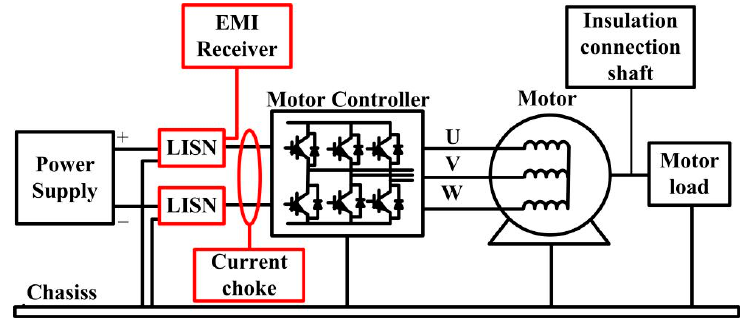
Figure 1. Conducted EMI emission system test setup for the AC motor drive system.